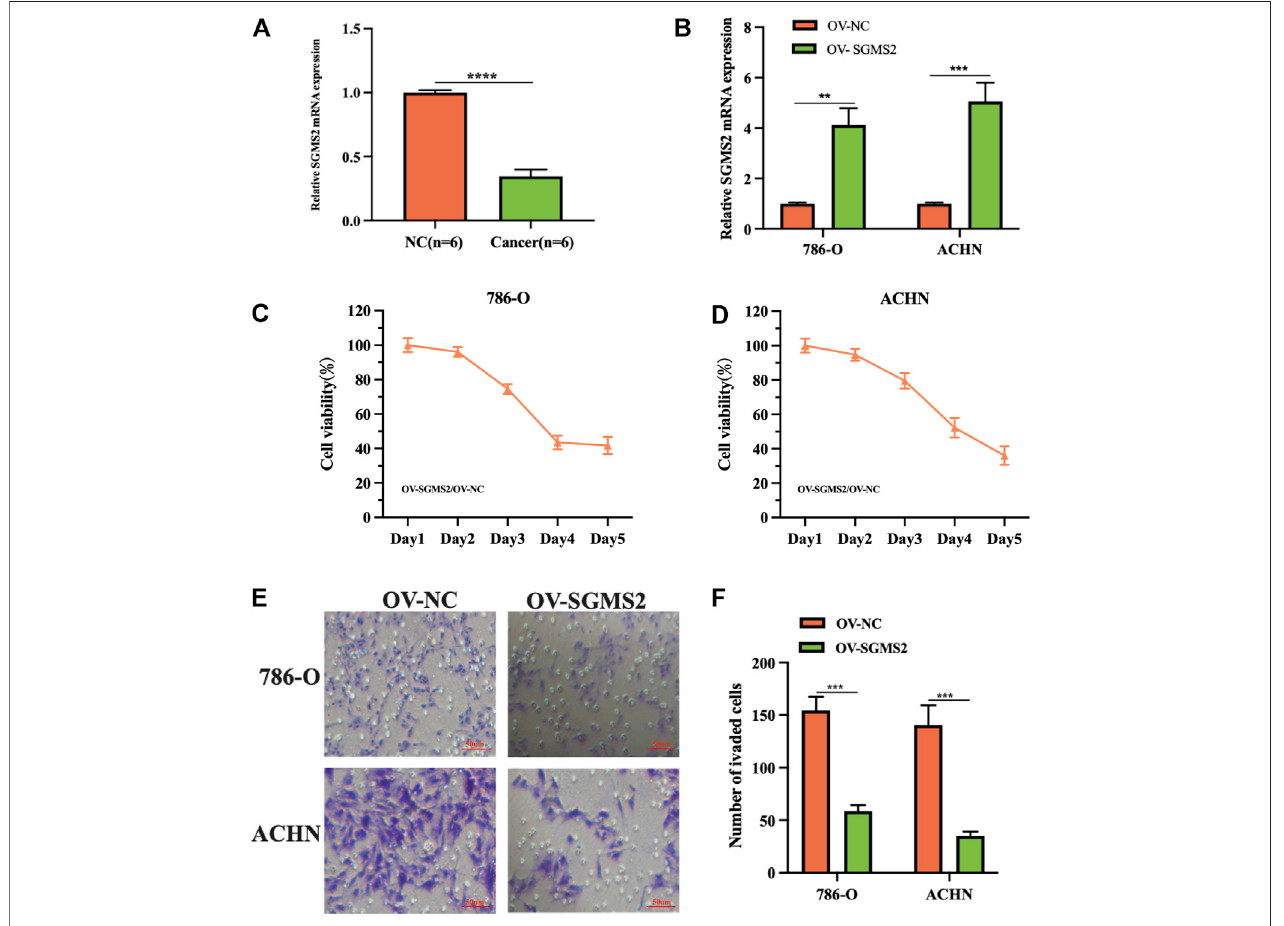
FIGURE 12 | Laboratory experiments explored the expression and biological role of SGMS2 in KIRC. (A) The histogram of the data of RT-PCR assay detecting SGMS2 mRNA expression in six pairs of KIRC pathological tissues. (B) The histogram was obtained by RT-PCR experiment to detect the transfection ef fi ciency data of SGMS2 plasmid. (C,D) Line graphs based on CCK8 cell proliferation assay data after overexpression of SGMS2 in 786-O and ACHN cell lines. (E,F) Light microscopy images of Transwell cell migration assays after overexpression of SGMS2 in 786-O and ACHN cell lines, and a corresponding histogram. ** p < 0.01, *** p < 0.001, **** p <